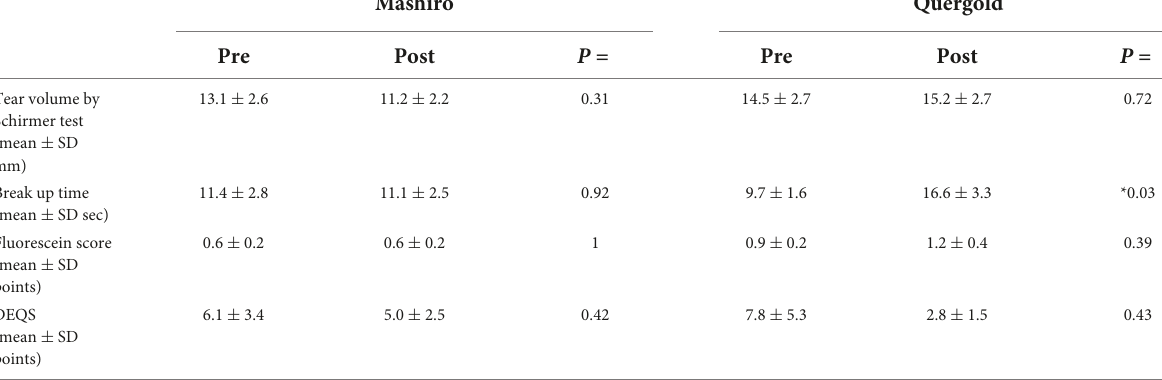
TABLE 3 Changes in tear function after consumption of onion powders with high and low quercetin content. Mashiro